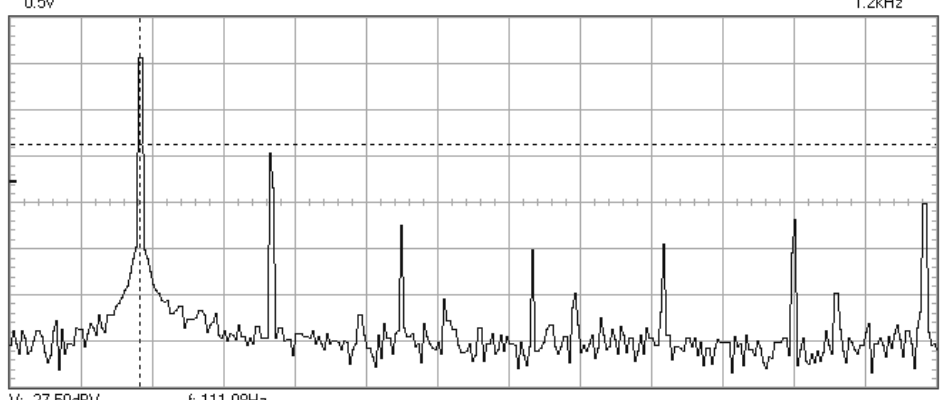
Figure 12. Amplitude spectrum recorded after 61,992 cycles at 114.8 Hz.